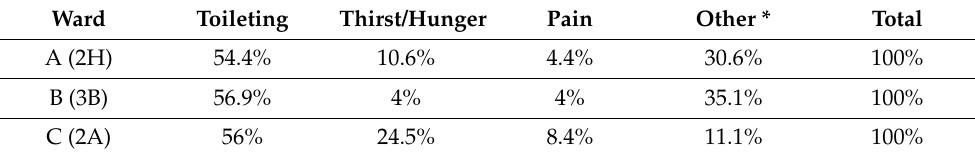
Table 3. PVM staff survey results-reasons reported for nurse attendance/intervention due to PVM.